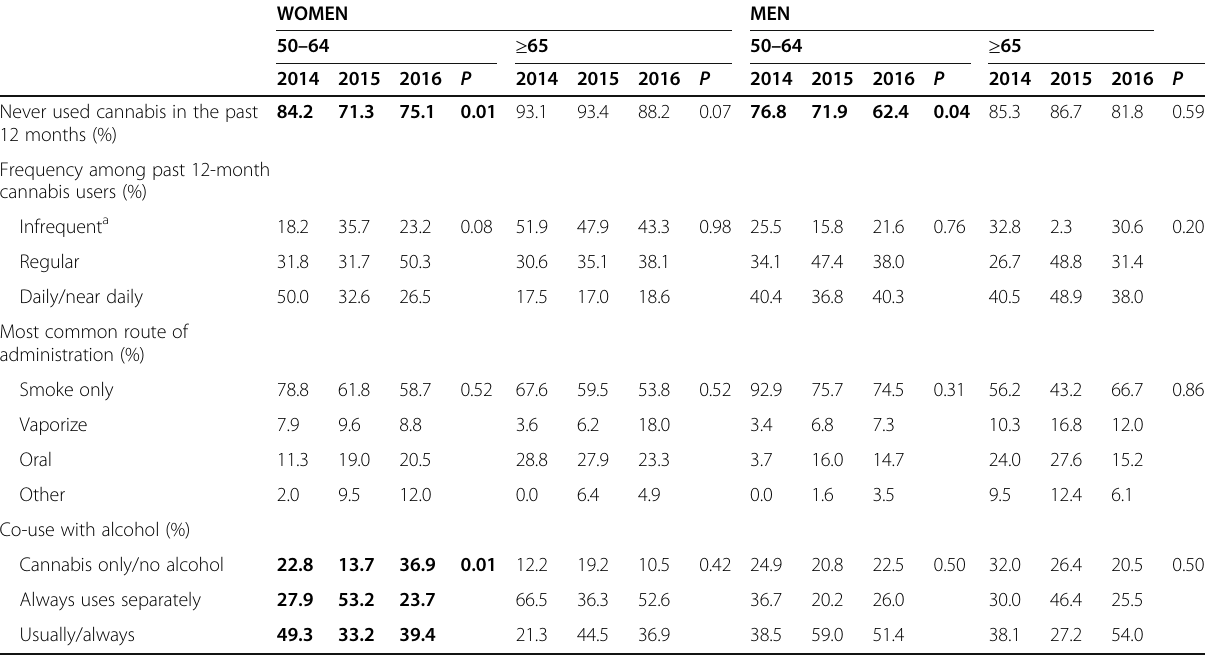
Table 2 Trends in prevalence (%) of past 12-month cannabis use across gender by age groups, 2014 – 2016 Washington state general population ( N = 5429)